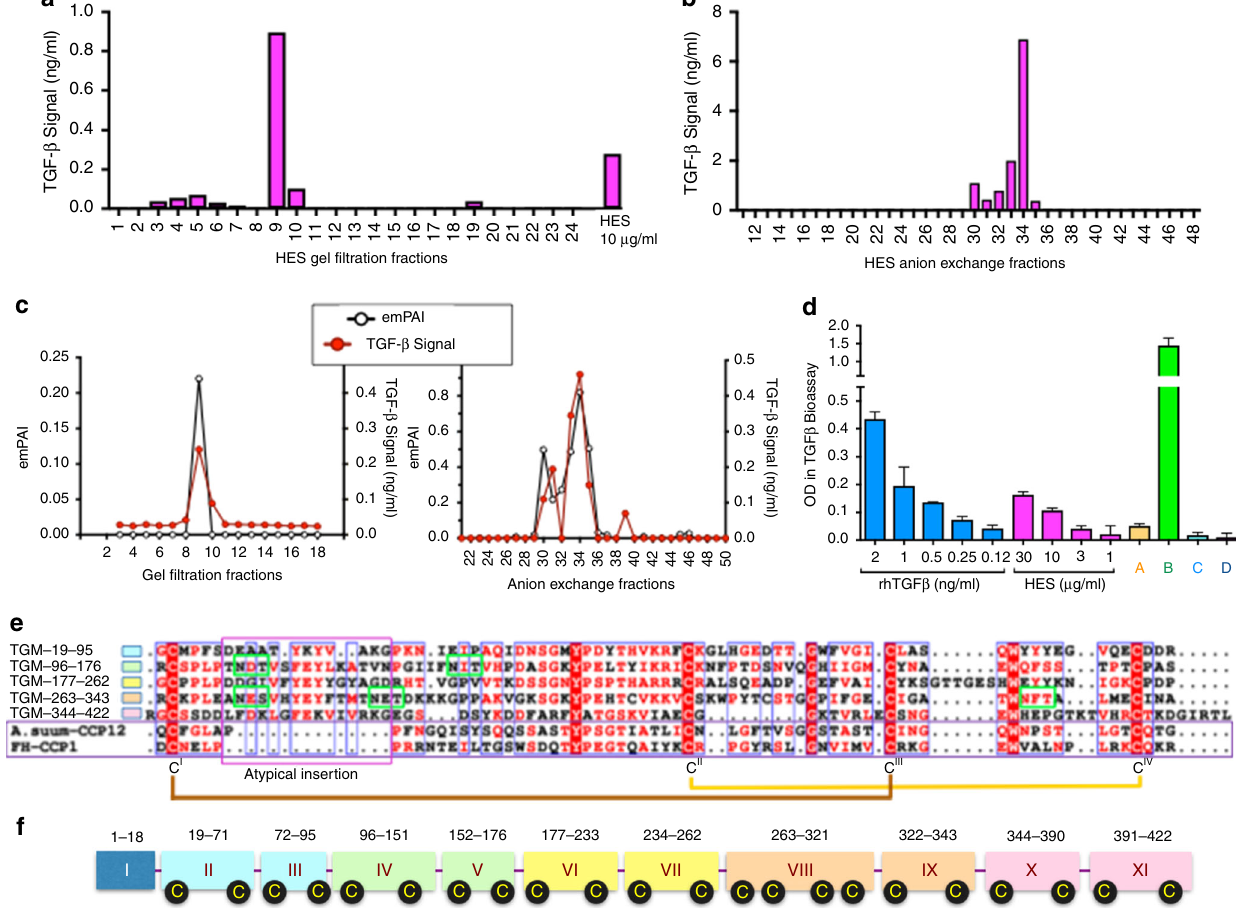
Fig. 1 Identi fi cation of Hp -TGM. a Fractionation of HES by gel fi ltration FPLC. 1 mg of HES was separated on a Superdex 200 10/300 GL column and 1 ml fractions collected for assay with MFB-F11 reporter cells; responses were calibrated with recombinant human TGF- β 1. b as a , fractionation by ion exchange FPLC on a Mono Q TM 5/50 G column. c Abundance of a candidate protein, Hp_I03161_IG00349_L1408, calculated by the exponentially modi fi ed Protein Abundance Index (emPAI) in each fraction, compared to the activation of TGF β -responsive cells by the same fraction. d TGF- β bioassay screen of four candidate recombinant clones designated A – D; clone B corresponds to candidate Hp_I03161_IG00349_L1408 shown in panel c . Supernatants of cells transfected with clones A – D were assayed in duplicate, and mean values ± SEM are shown. Two-tailed t tests found Clone B to be signi fi cantly ( p < 0.05) higher than all others. e Alignment of fi ve similar domains within Hp- TGM encompassing the entire amino acid sequence apart from the predicted signal peptide (aa 1 – 18), with conserved cysteine (white on red) and other residues indicated, together with a Complement Control Protein (CCP) module from the nematode Ascaris suum (domain 12 of ASU_08405, aa 954 – 1018), and an archetypal CCP domain, human Factor H module 1 (X07523, aa 20 – 83). Other conserved residues are shown in red and potential N -glycosylation sites outlined in green. Amino acid positions for each domain of Hp-TGM are indicated on the left. Note the presence of a 15-aa insertion near the N-terminal of each domain of Hp -TGM which is not typical of the CCP family. Positions of disul fi de bonds in Factor H are shown below the alignment by linked cysteine residues CI – CIV. f Exon-intron structure of Hp -TGM in the H. polygyrus genome; domains are colored corresponding to symbols in panel e ; positions of cysteine residues indicated in black